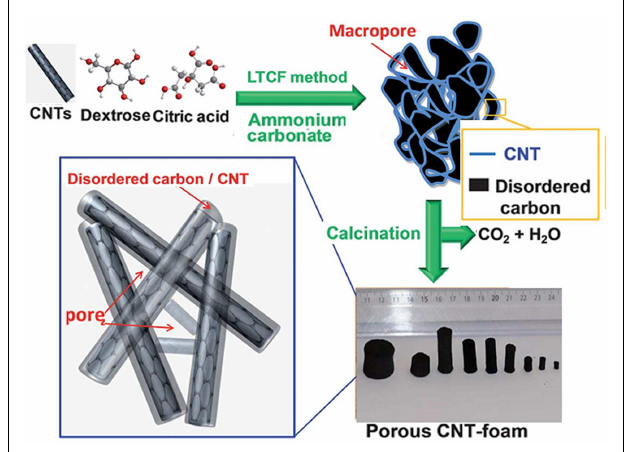
FIGURE 1 | Illustration of a low temperature chemical fusion method for the synthesis of porous CNT-foam composites . Adapted with permission from Liu et al. (2013b). Copyright 2013 Royal Society of Chemistry.